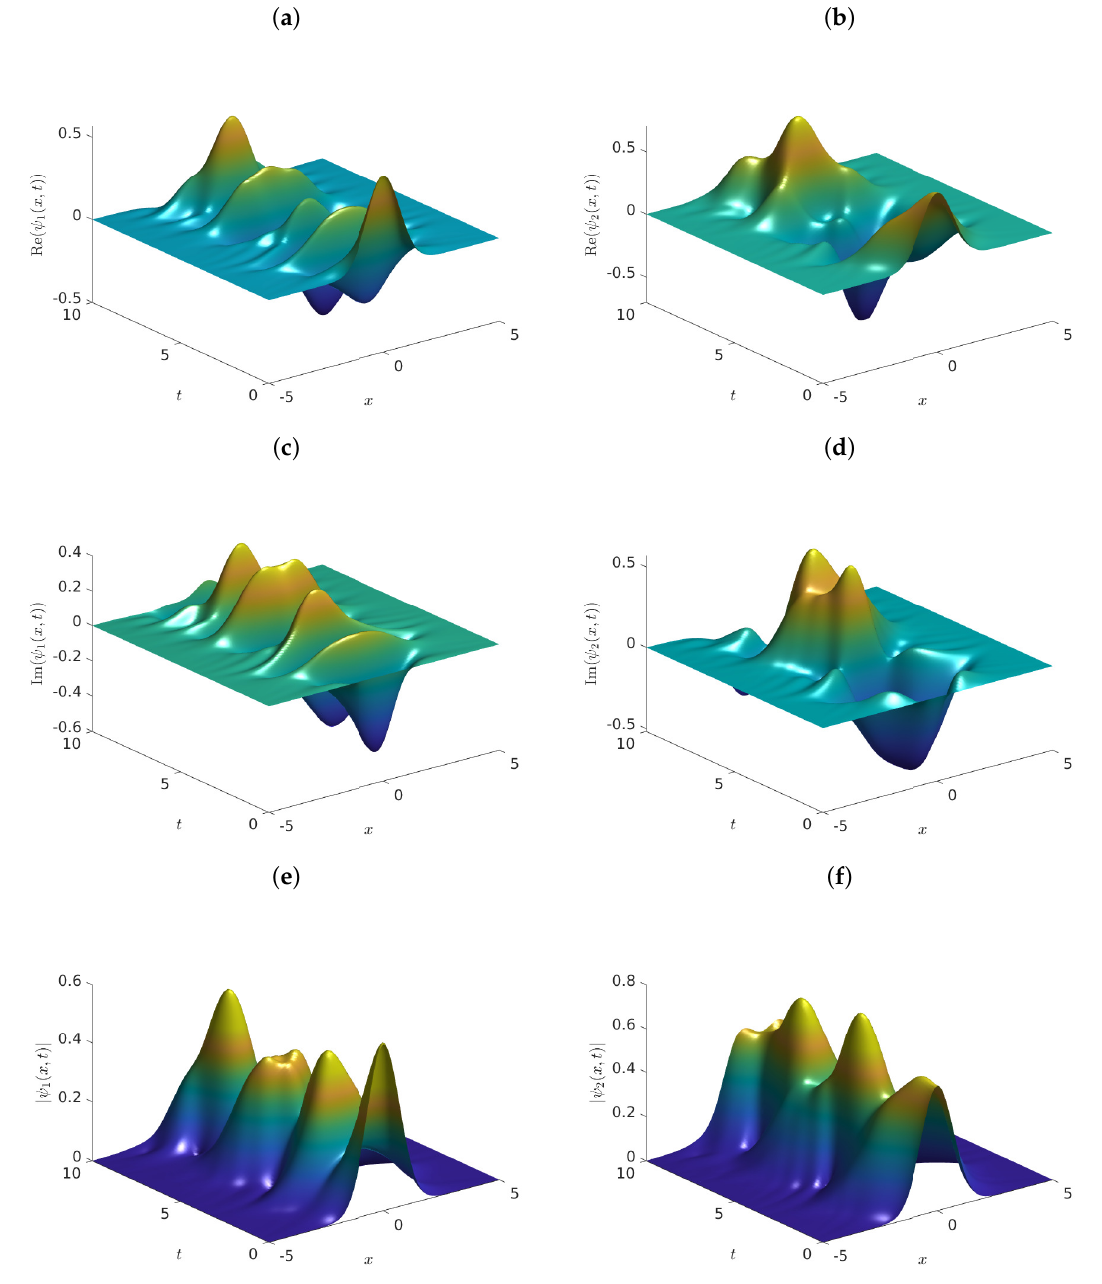
x 2 , and initial data φ 1 ( x ) = φ 2 ( x ) = 2